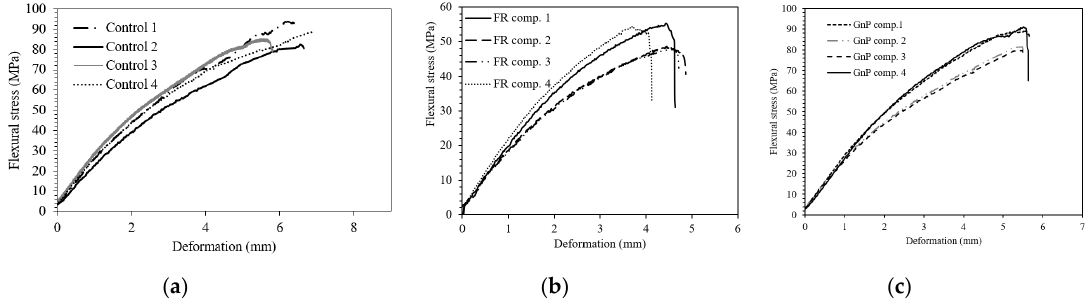
Figure 12. The bending stress-displacement curves of ( a ) Control, ( b ) FR composite and ( c ) GnP composite. Table 5. Flexural properties of the composites.